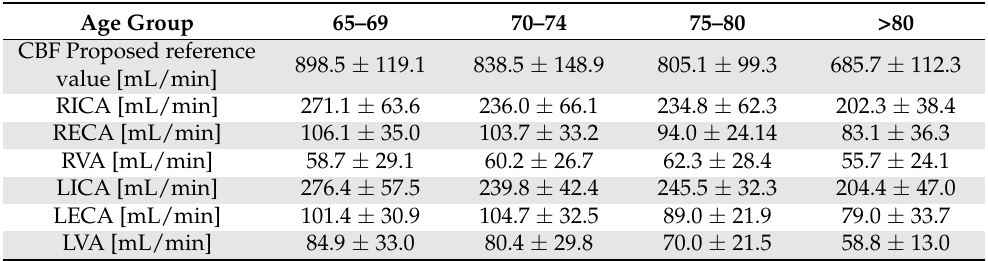
Table 2. Reference flow volume in extracranial arteries RICA, LICA—right and left internal carotid artery. RECA, LECA—right and left external carotid artery. RVA, LVA—right and left vertebral artery. Values are presented as the average ± standard